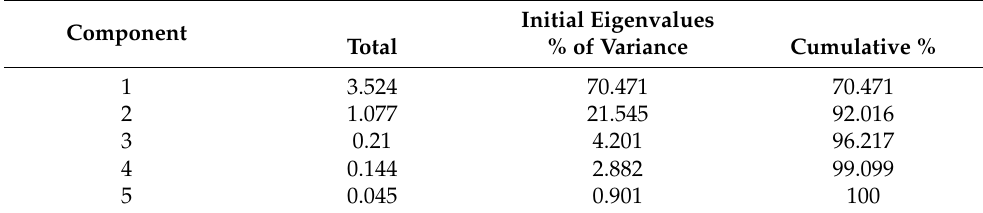
Table 6. Principal component eigenvalue and variance contribution rate.